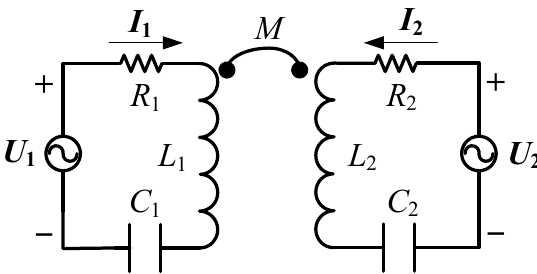
phasor quantities.